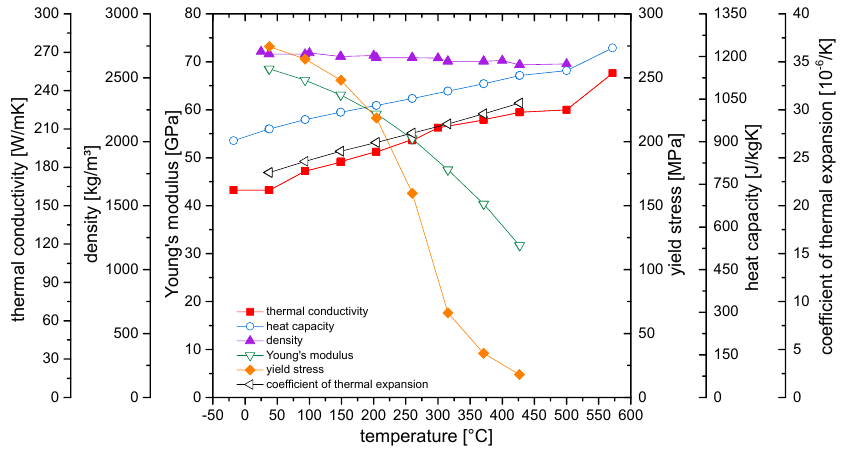
Figure 3. Temperature-dependent thermal and mechanical properties of